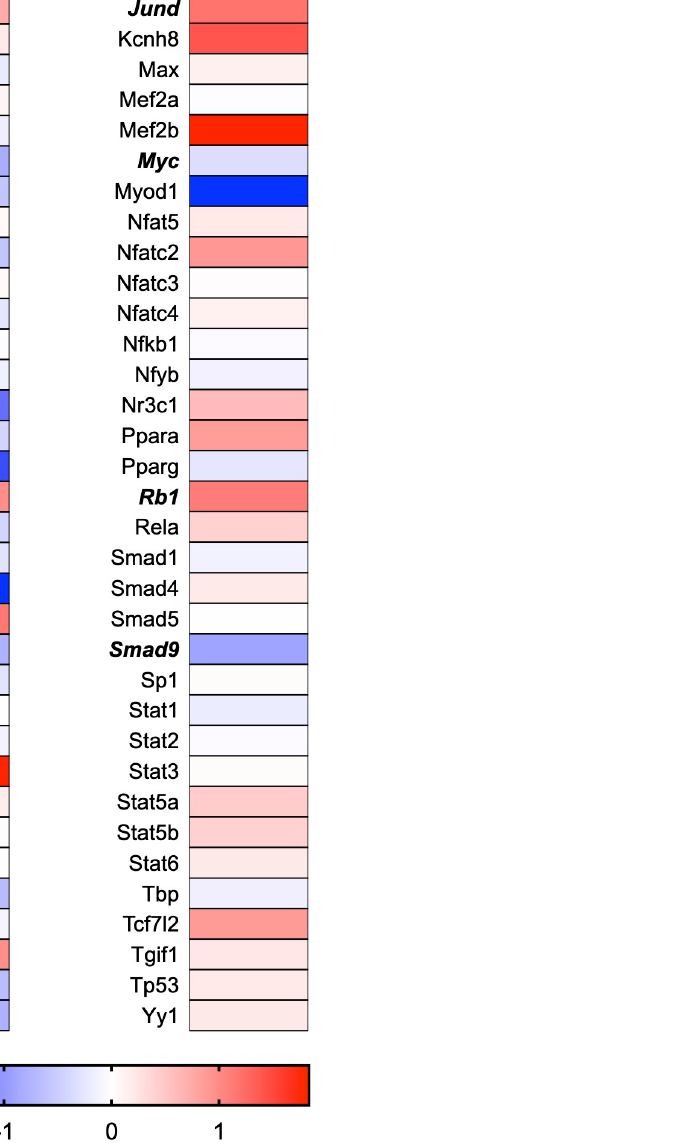
Fig 12. Transcription factors heat map. Bold text indicates significantly altered gene